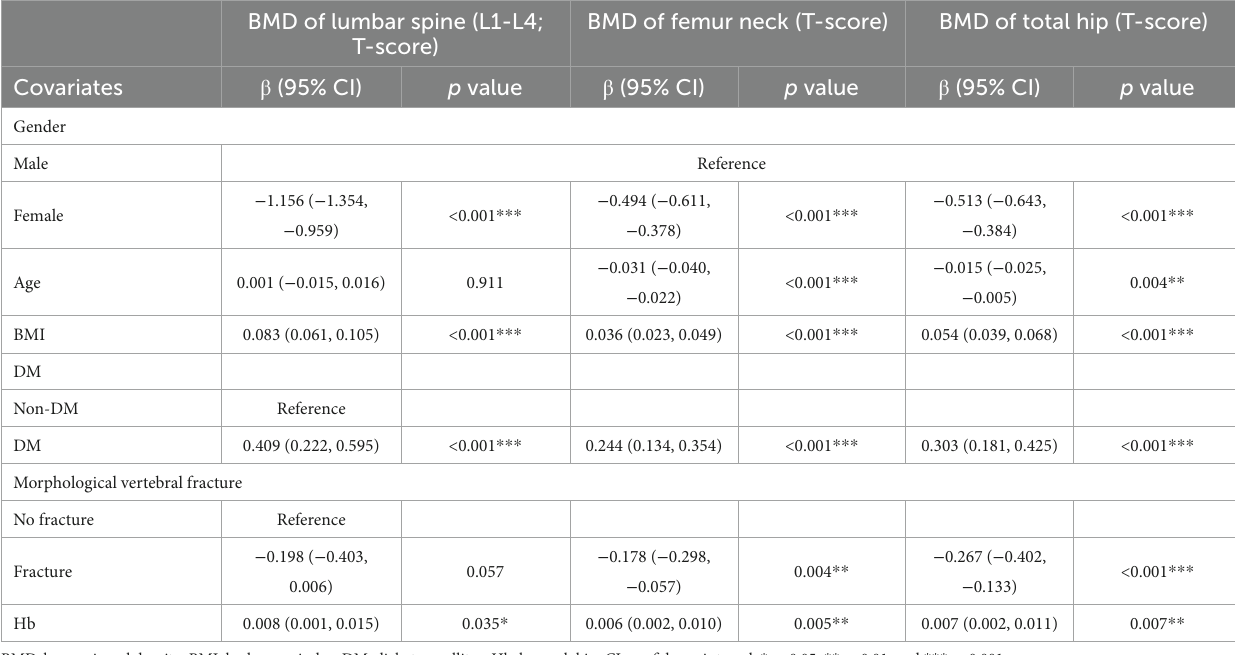
TABLE 2 Multivariate linear regression analysis of clinical parameters and BMD T-score. BMD of lumbar spine (L1-L4; BMD of femur neck (T-score) T-score)